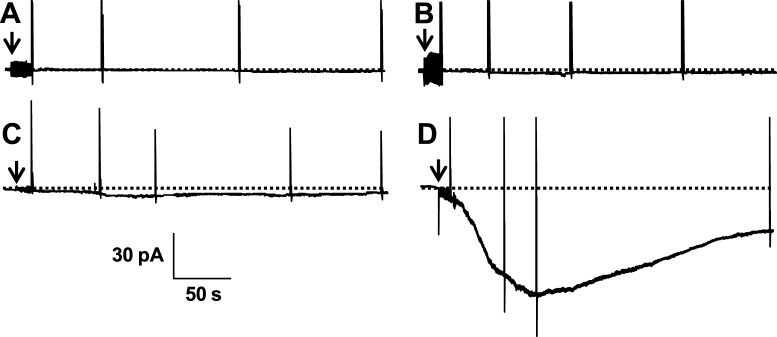
Currents elicited by SlitBest1b in CHO transfected cells.No currents were recorded with 100 µM intracellular Ca2+ from non-transfected cells (A) and from cells transfected only with GFP (B). CHO-K1 cells transfected with SlitBest1b and GFP did not exhibit any current when recorded with a 20 nM intracellular Ca2+ solution (C) whereas with a 100 µM intracellular Ca2+ solution an inward current was elicited (D). Recording were made at −60 mV holding potential. Arrows indicate the transition from cell-attached to whole-cell configuration. Dotted horizontal lines are zero current levels.